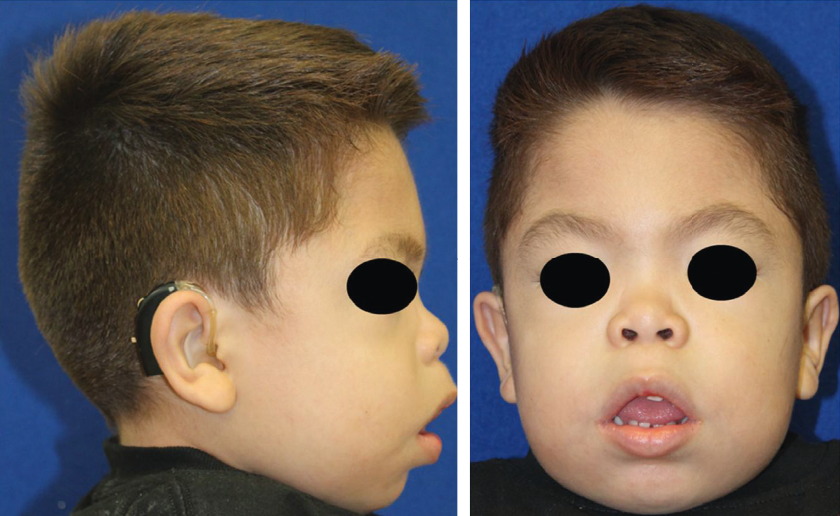
Figure 2: Extraoral views. Note the audition appliances.